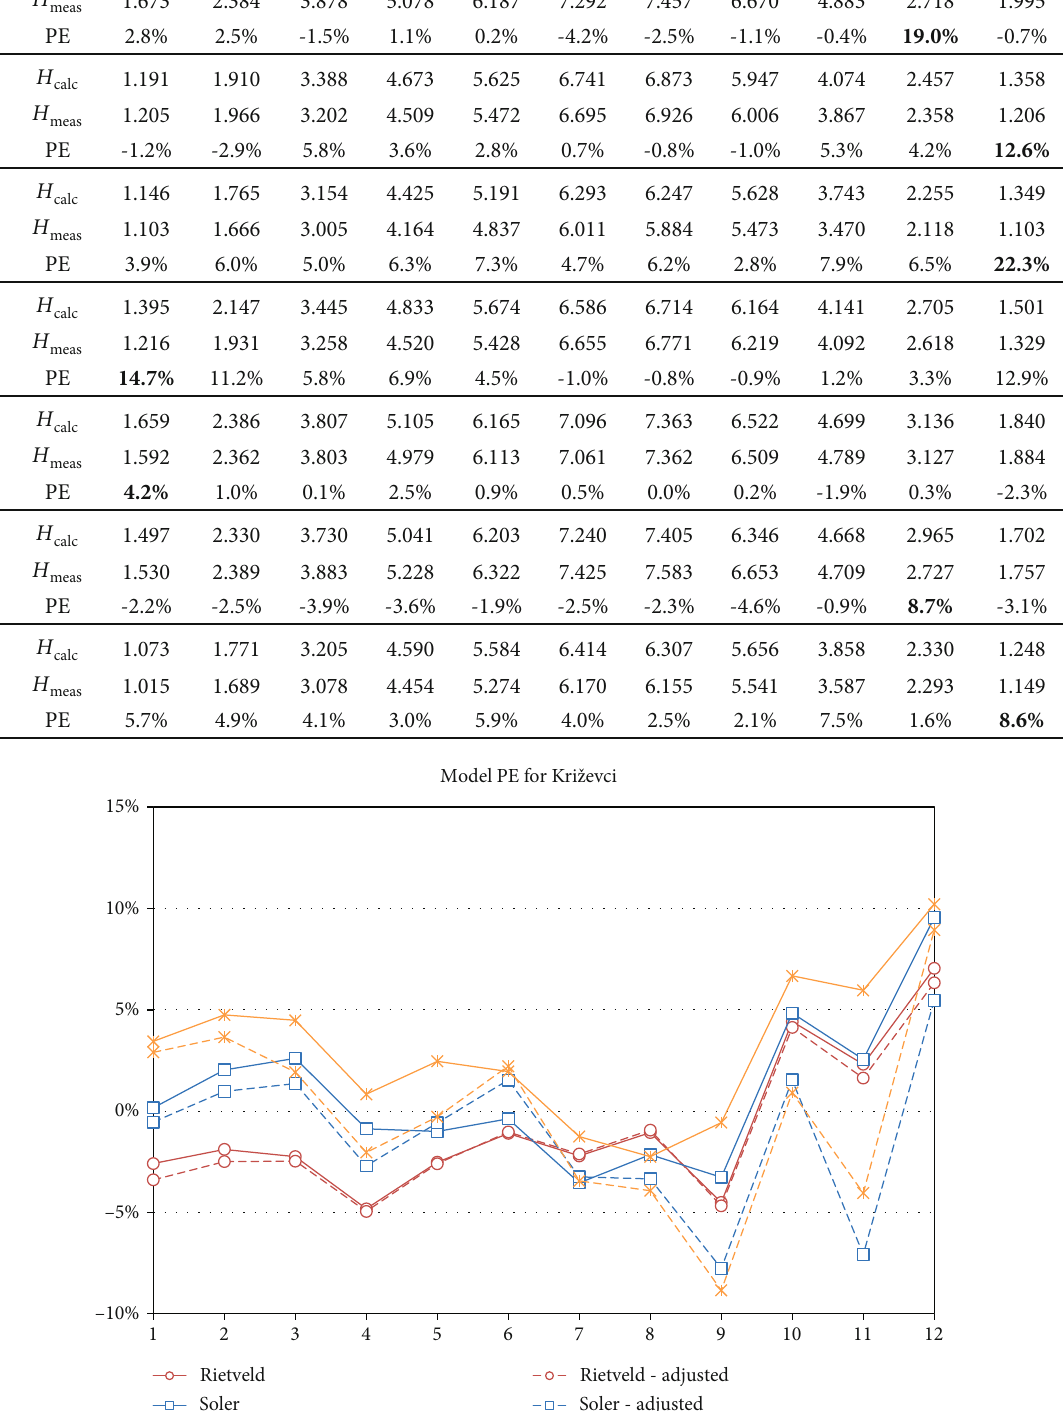
Table 6: Comparison of monthly average daily global horizontal radiation calculated using Dogniaux-Lemoine monthly dependent model H with measurements H calc Location